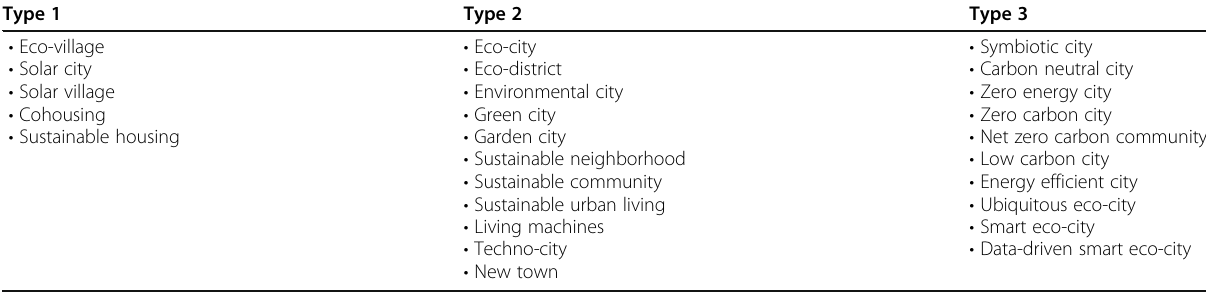
Table 3 Three types of eco-city models Type